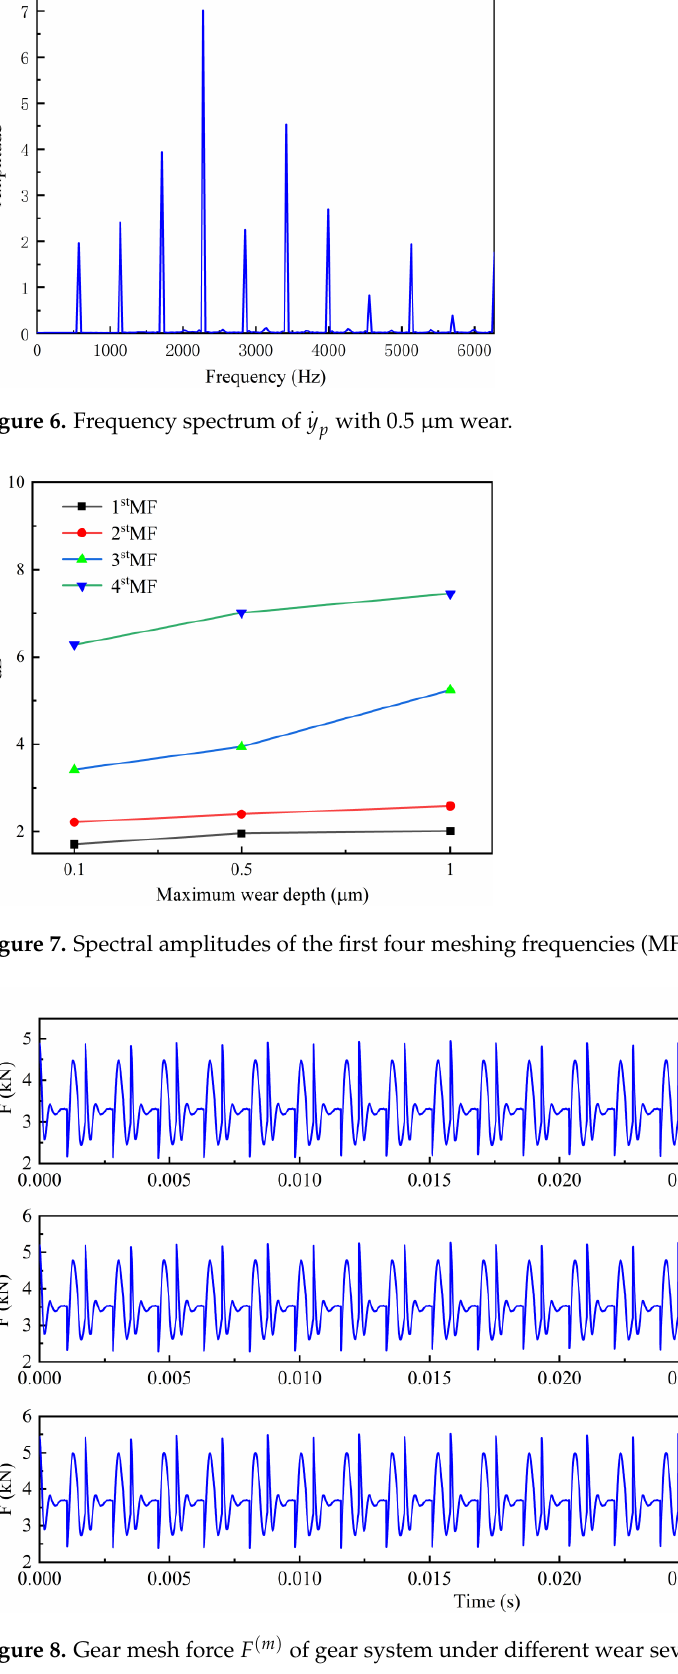
Figure 8. Gear mesh force 𝐹 (𝑚) of gear system under different wear severities.